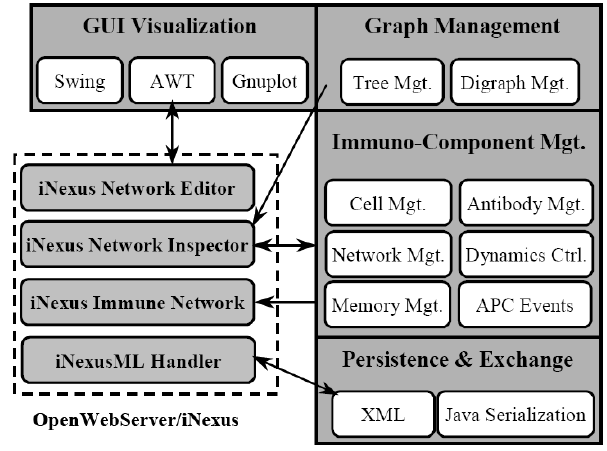
Figure 5. Structure of